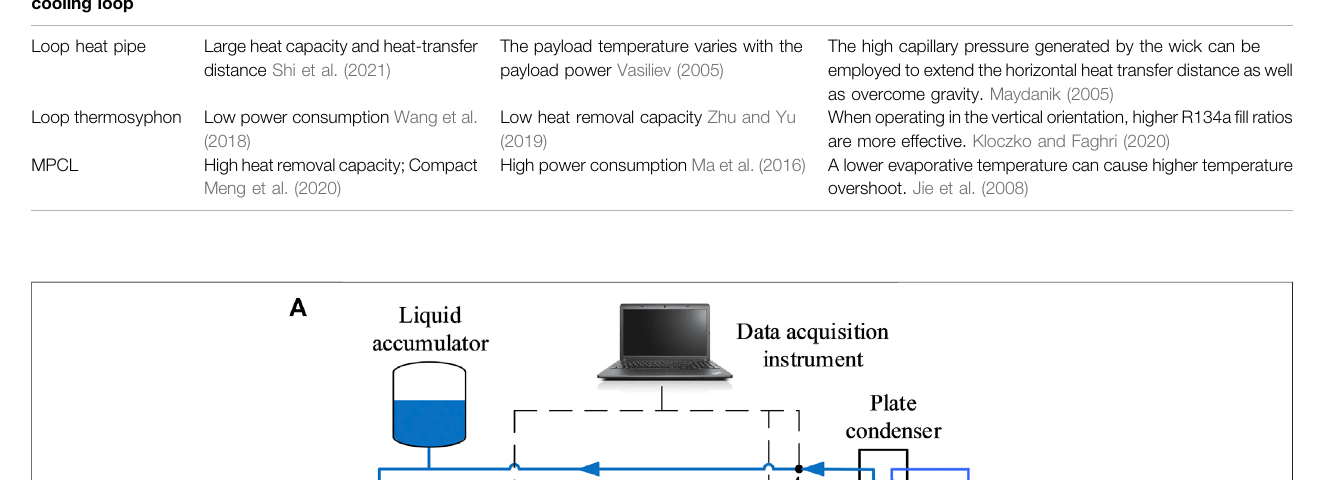
Frontiers in Energy Research |